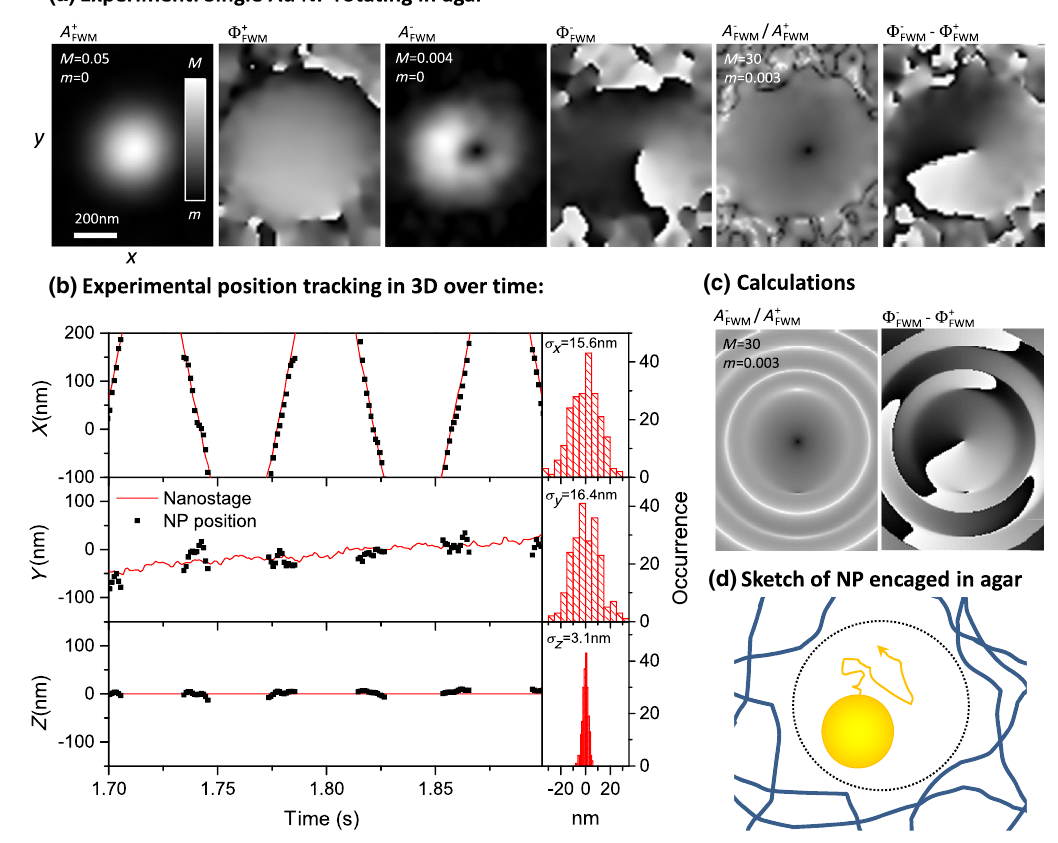
FIG. 6. Rotational averaging of nanoparticle asymmetry. We show single 25-nm-radius gold NP freely rotating while encaged in an agarose gel pocket (see sketch). (a) Experimental xy scan of the cross- and co-circularly polarized FWM field in the focal plane, using a 1.27 NA water-immersion objective. We show the linear grey scale from − π to π for phases and from m to M for field amplitudes, with M given relative to the maximum A þ 70 μ W 2 r . The amplitude ratio is on a logarithmic scale. The pump (probe) power at the sample was ( 10 μ W) with pump (probe) filling factor 2.15 (0.97). Measurements were performed with 0.5-ms-pixel dwell time, 0.5-ps pump-probe delay time, and 13-nm pixel size in plane. Data are shown as spatial averages over an effective area of 3 × 3 pixels. (b) Time traces of the retrieved-particle-position coordinates in 3D from the measured FWM amplitude and phase (symbols) compared with the coordinates from the scanning piezoelectric sample stage (lines). Traces are binned to an equivalent 1 ms acquisition time per point. After subtracting the stage coordinates, histograms of the difference between consecutive points are shown, and the corresponding localization precisions are indicated (see text). (c) Calculated FWM field ratio assuming a polarization tensor that projects the longitudinally polarized field component into the ð x; y Þ plane (see